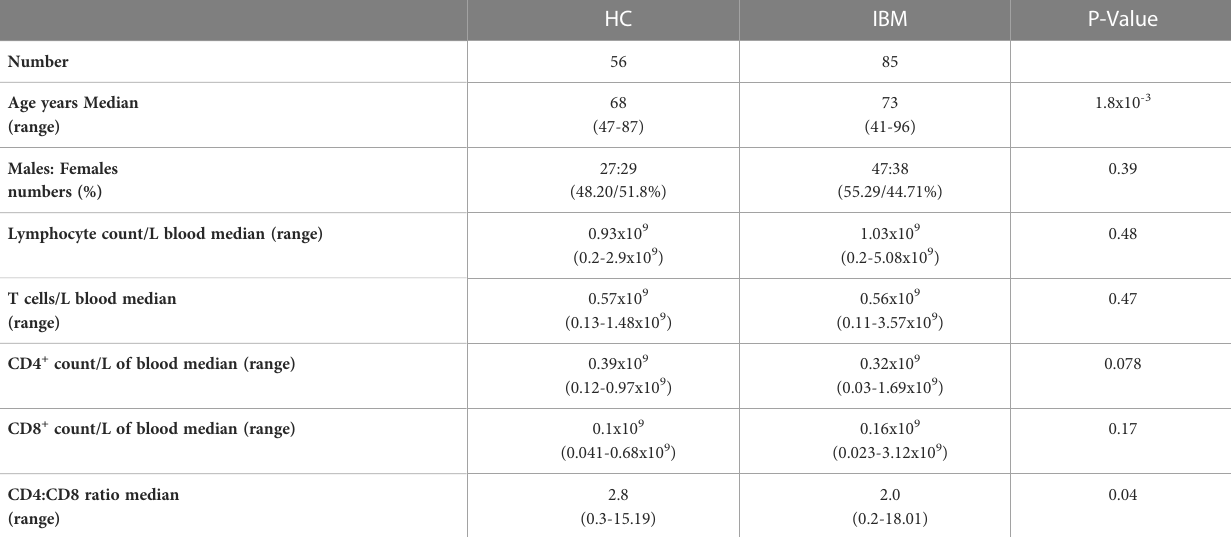
TABLE 1 Demographic and hematological information in IBM and HC